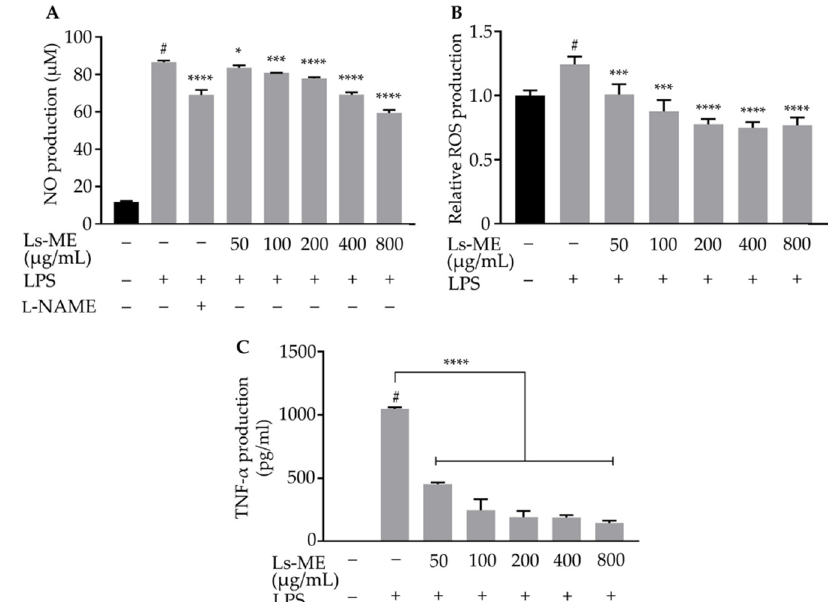
Figure 2. The suppression e ff ects of Ls-ME on LPS-induced NO, ROS and TNF- α production in RAW 264.7 macrophages. Cells were cultured with serial concentrations of Ls-ME for 24 h, followed by treatment with LPS (1 µ g / mL) for 18 h. The NO levels in LPS-stimulated cells were measured using the Griess assay ( A ). The NO level observed upon pretreatment with L-NAME at the concentration of 100 µ M was used as a positive control. Intracellular ROS accumulation was evaluated ( B ). TNF- α production in LPS-treated cells was determined using ELISA ( C ). Data obtained from three replicates are represented as mean ± SD. # p < 0.05 is expressed in comparison with cells incubated alone; * p < 0.05; *** p < 0.001 and **** p < 0.0001 are expressed in comparison with LPS treatment only.